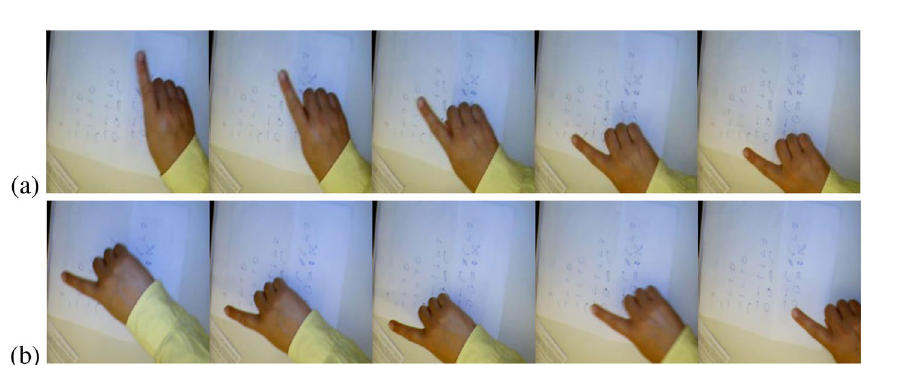
Figure 12. The sample frames of the confused gestures. ( a ) rotate down, ( b ) move downright.